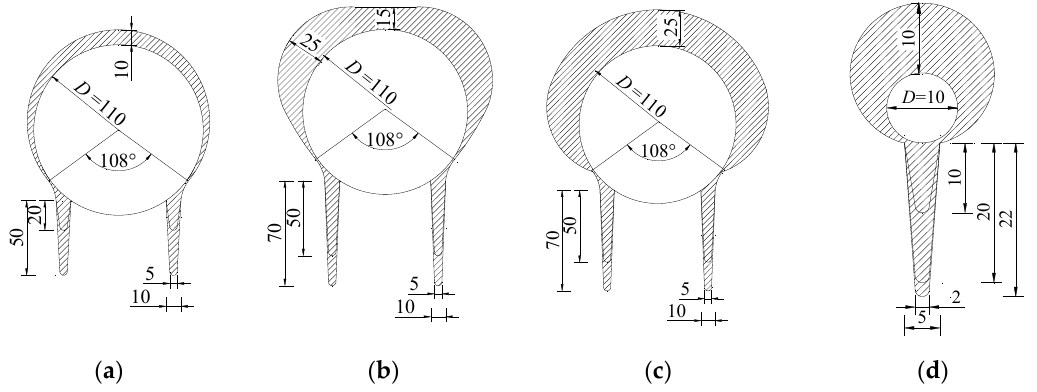
Figure 22. Schematic diagram of iced pipeline and guardrail (mm): ( a ) pipeline with crescent-shaped ice, ( b ) pipeline with D-shaped ice, ( c ) pipeline with sector-shaped ice, and ( d ) guardrail with crescent-shaped ice.